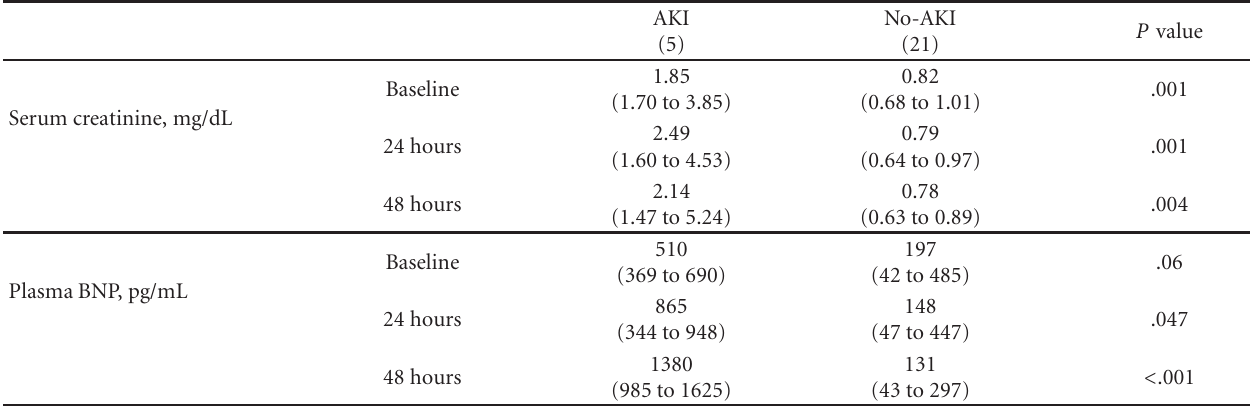
Table 3: Median of creatinine and BNP during 48 hours of ICU stay for patients with or without AKI on admission to ICU. The increase in BNP of AKI patients is significant ( P = .